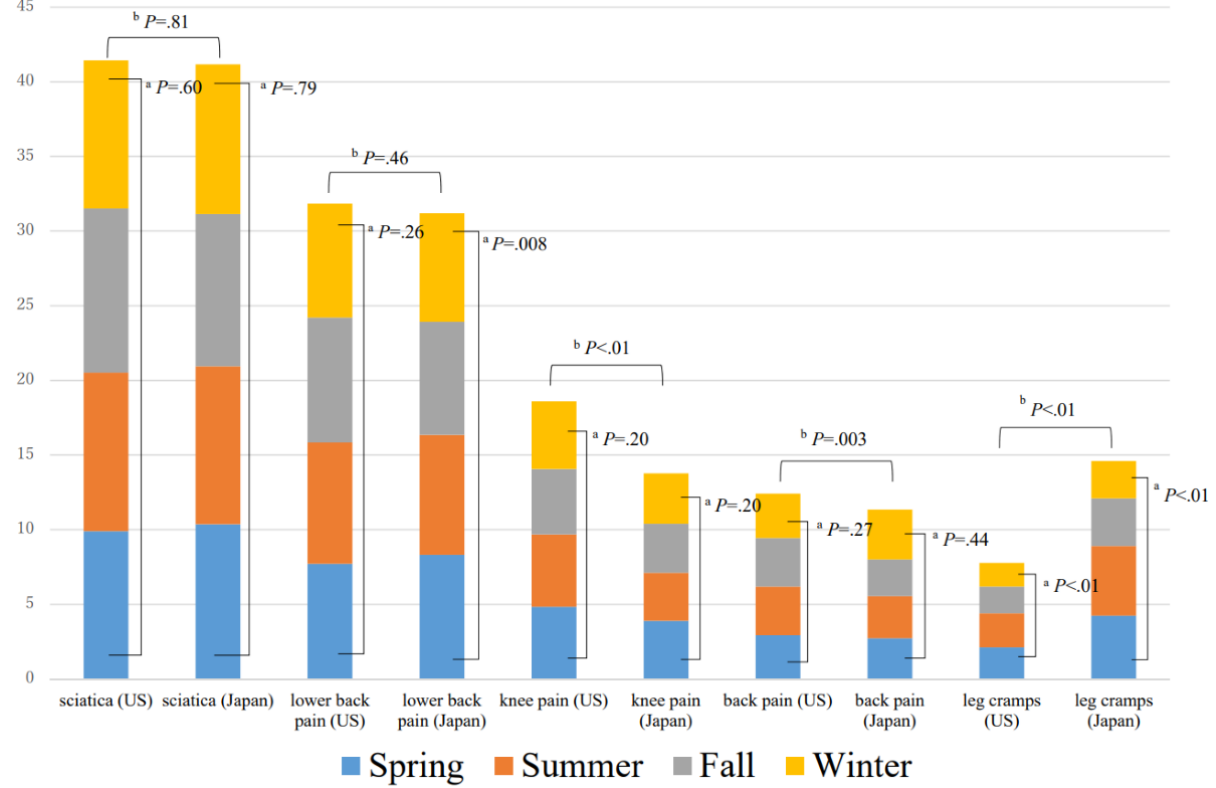
Figure 2. Comparison of musculoskeletal pain–related searches per month for each season (2016-2019) Vertical axis: Monthly searches per 10,000 people. a Differences between seasons (Kruskal–Wallis test); b Differences between the United States and Japan (Mann–Whitney U test).